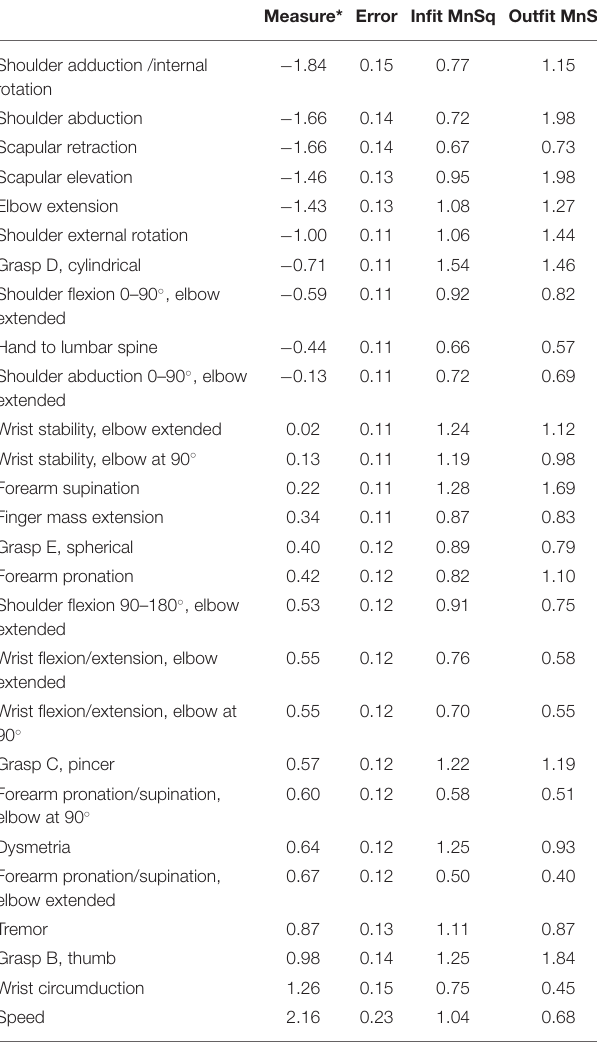
TABLE 2 | Infit/outfit statistics of the 28-item Fugl Meyer Assessment for Upper Extremity † .